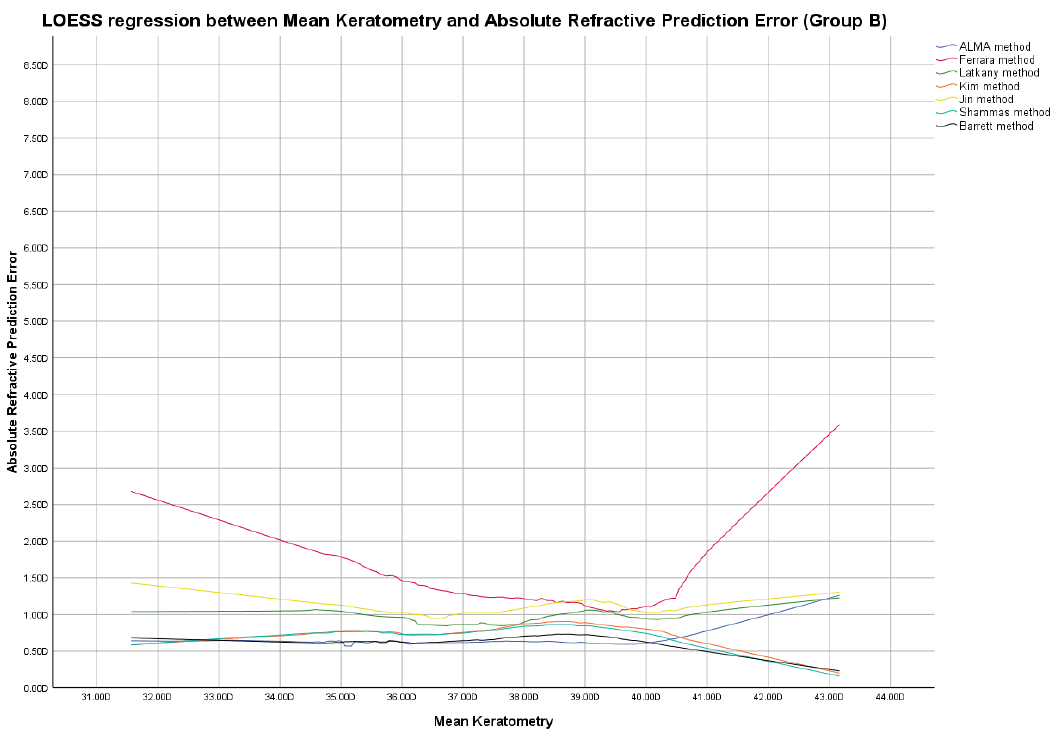
Figure 4. Locally estimated scatterplot smoothing (LOESS) curve between refractive prediction errors generated for each examined formula and the related mean keratometry value. (Group B).